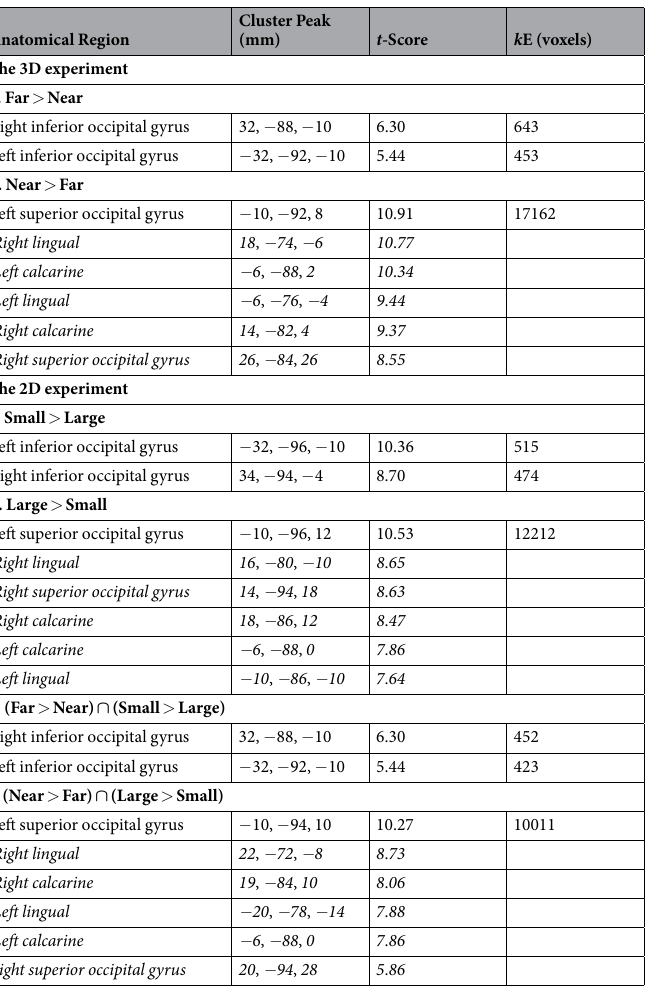
Table 1. The main effect of the depth of objects in the virtual 3D experiment and the main effect of the size of stimuli in the 2D experiment. The coordinates (x, y, z) correspond to MNI coordinates. Displayed are the coordinates of the maximally activated voxel within a significant cluster as well as the coordinates of relevant local maxima within the cluster (in